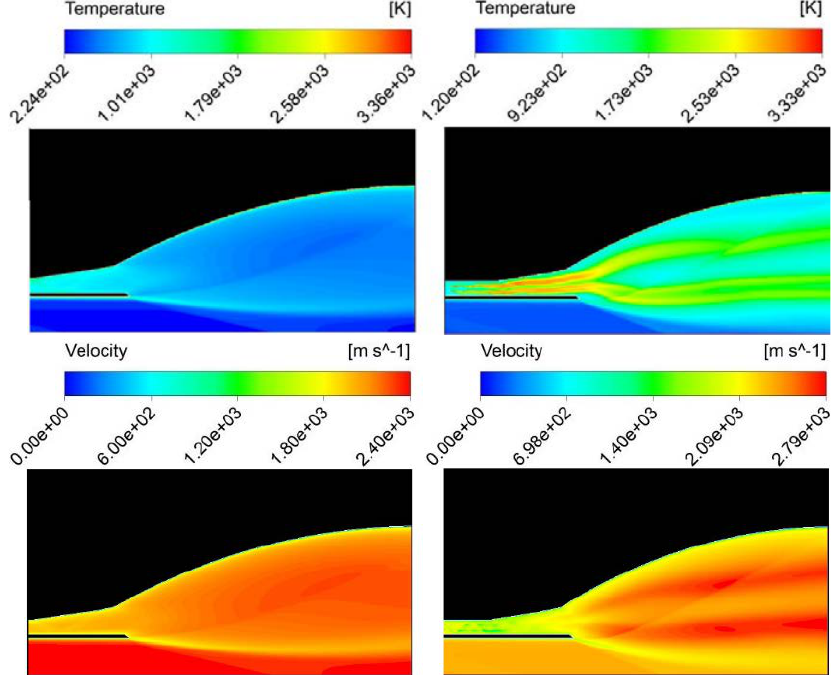
Figure 20. Temperature (top) and velocity contours (bottom) of DP102 for cold flow ( left ) and hot flow ( right ).